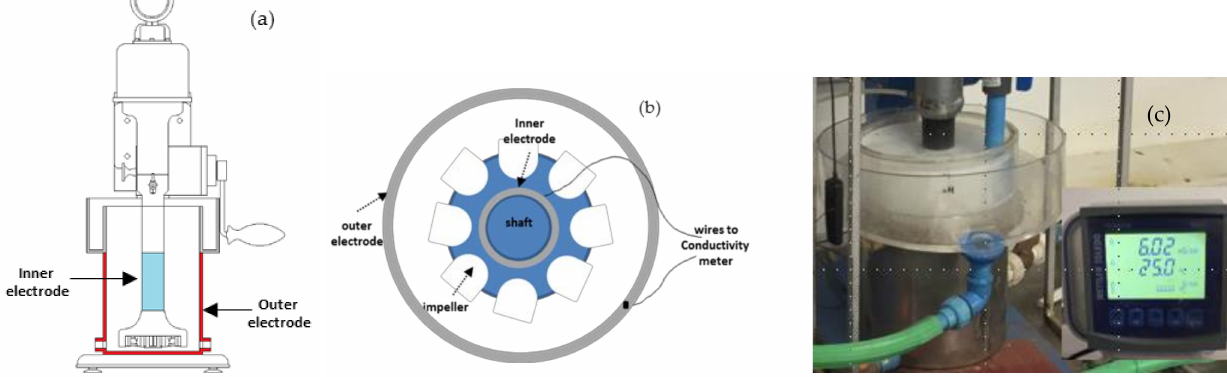
Figure 1. Dual flotation–conductivity cell. ( a ) Lateral view, ( b ) top view, ( c ) photograph of the flotation vessel and front panel of the conductivity meter M300 (Metler Toledo, Columbus, OH,